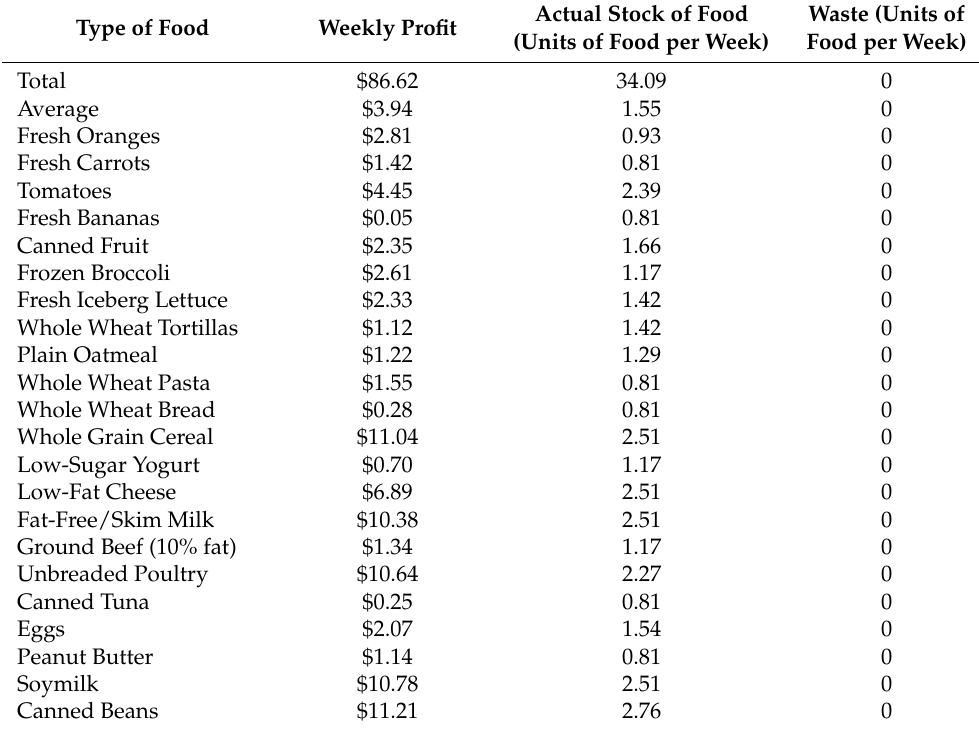
Table A3. Simulation Results for the Minneapolis SFO.